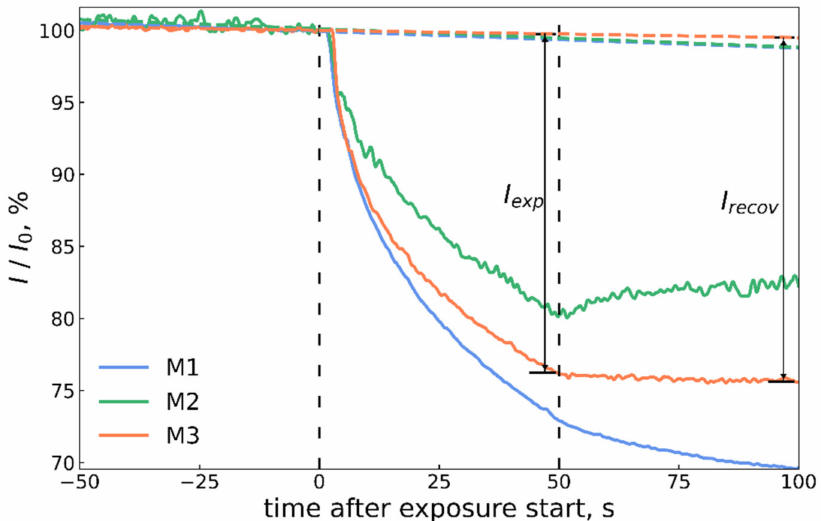
Figure 12. Fluorescence responses of materials M1 – M3 towards NB vapors in saturated vapor scenario. Vertical dashed lines mark the vapor exposure